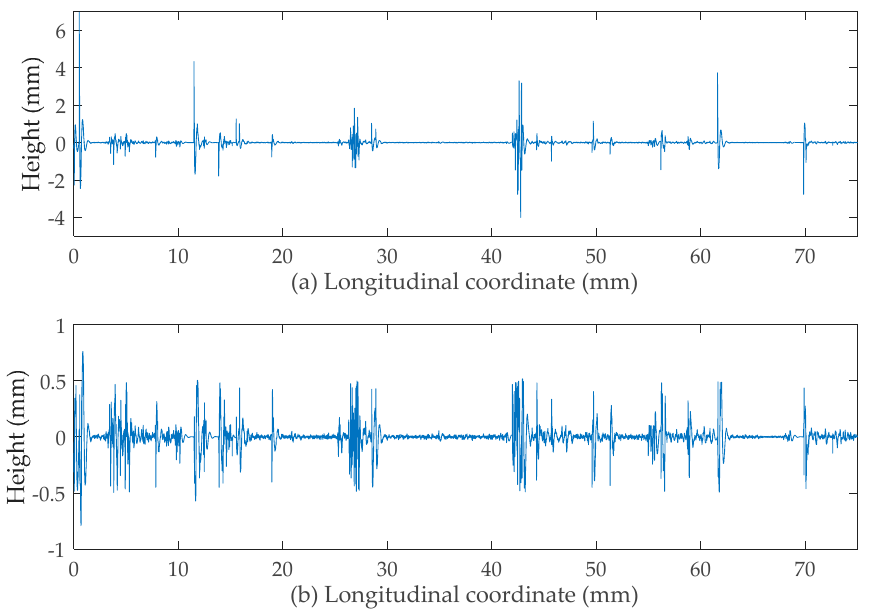
Figure 8. ( a ) Micro-texture with spikes and ( b ) without spikes.